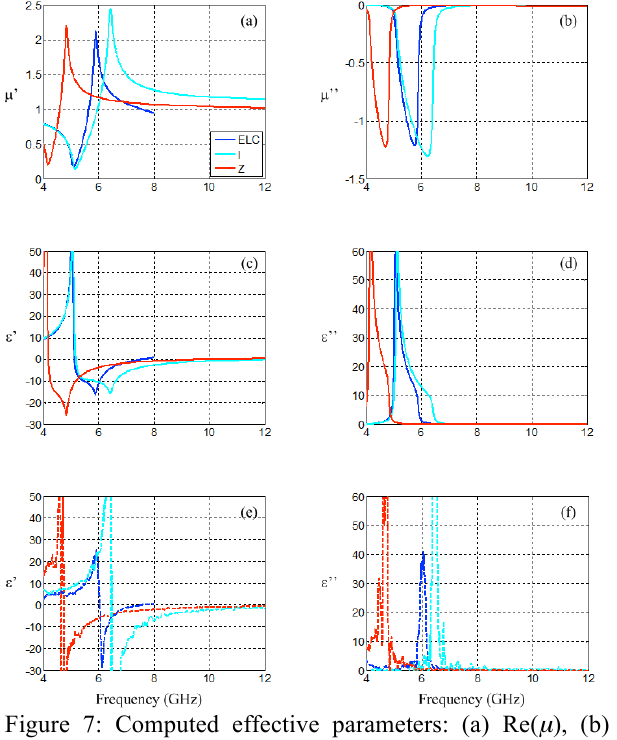
Figure 7: Computed effective parameters: (a) Re( µ ), (b) Im( µ ), (c) Re( ε ), and (d) Im( ε ). Measured effective parameters: (e) Re( ε ) and (f) Im( ε